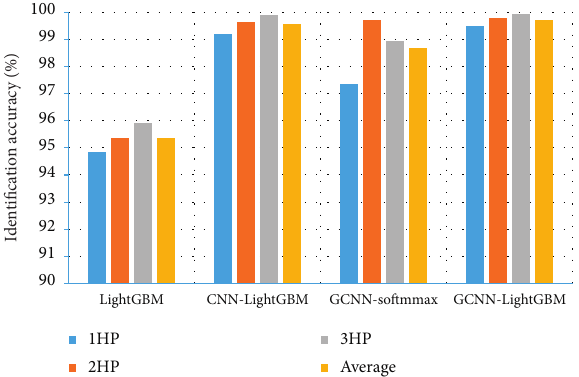
Figure 6: The classification accuracy of each model under the variable load